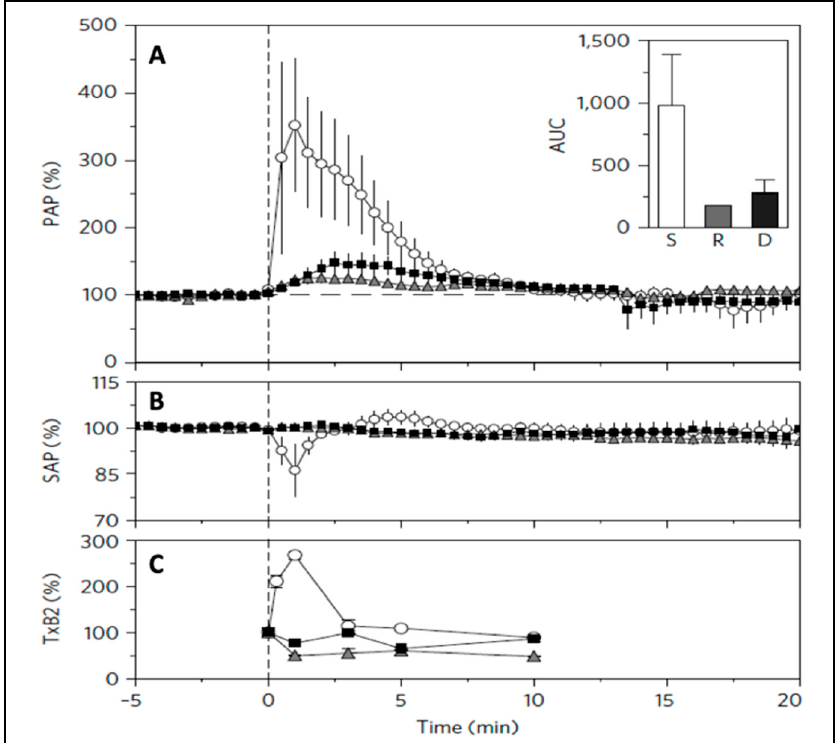
Figure 4. Changes of hemodynamic parameters in pigs after i.v. injection of polystyrene nanoparticles of different shape: spheres (circles), rods (triangles), and disks (squares). Time-dependent changes in pulmonary arterial pressure (PAP) ( A ), systemic arterial pressure (SAP) ( B ), and thromboxane B2 (TxB2) ( C ) following particle injection compared with background (resting phase, before 0 min). Particles (on an equivalent surface area of ~114,300 mm 2 per 20 kg body weight) were injected at 0 min. Inset: integrated area under the curve (AUC) of the changes in PAP during the first 10 min of injection. d, the results from pig experiments are expressed as mean ± SEM (n = 3). Reproduced from Ref. [44] with permission.